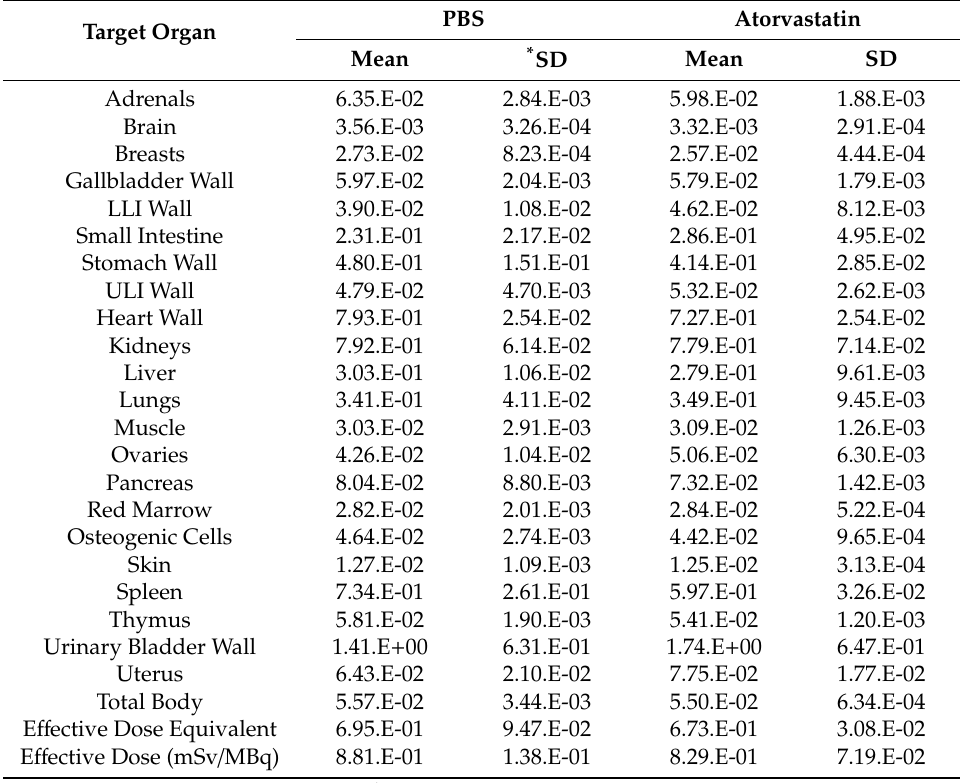
Table 1. Estimated absorbed doses (mSv / MBq). Target